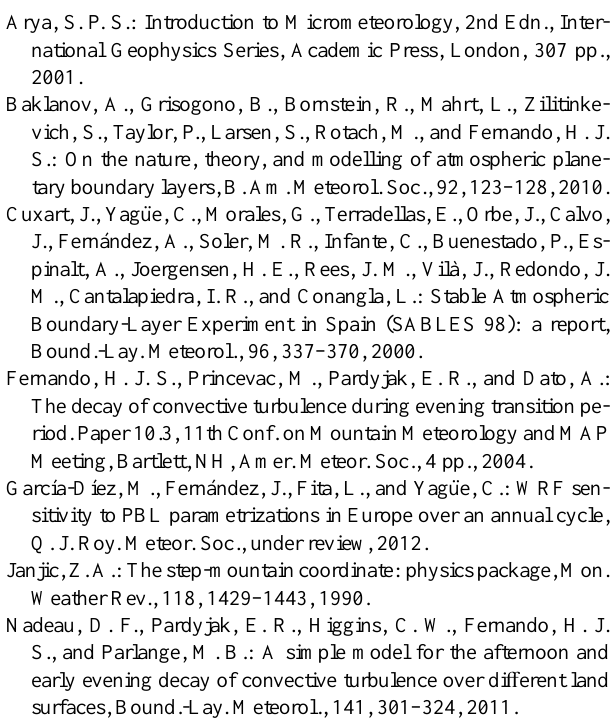
“m” and “o” refer to modelled or observed data,